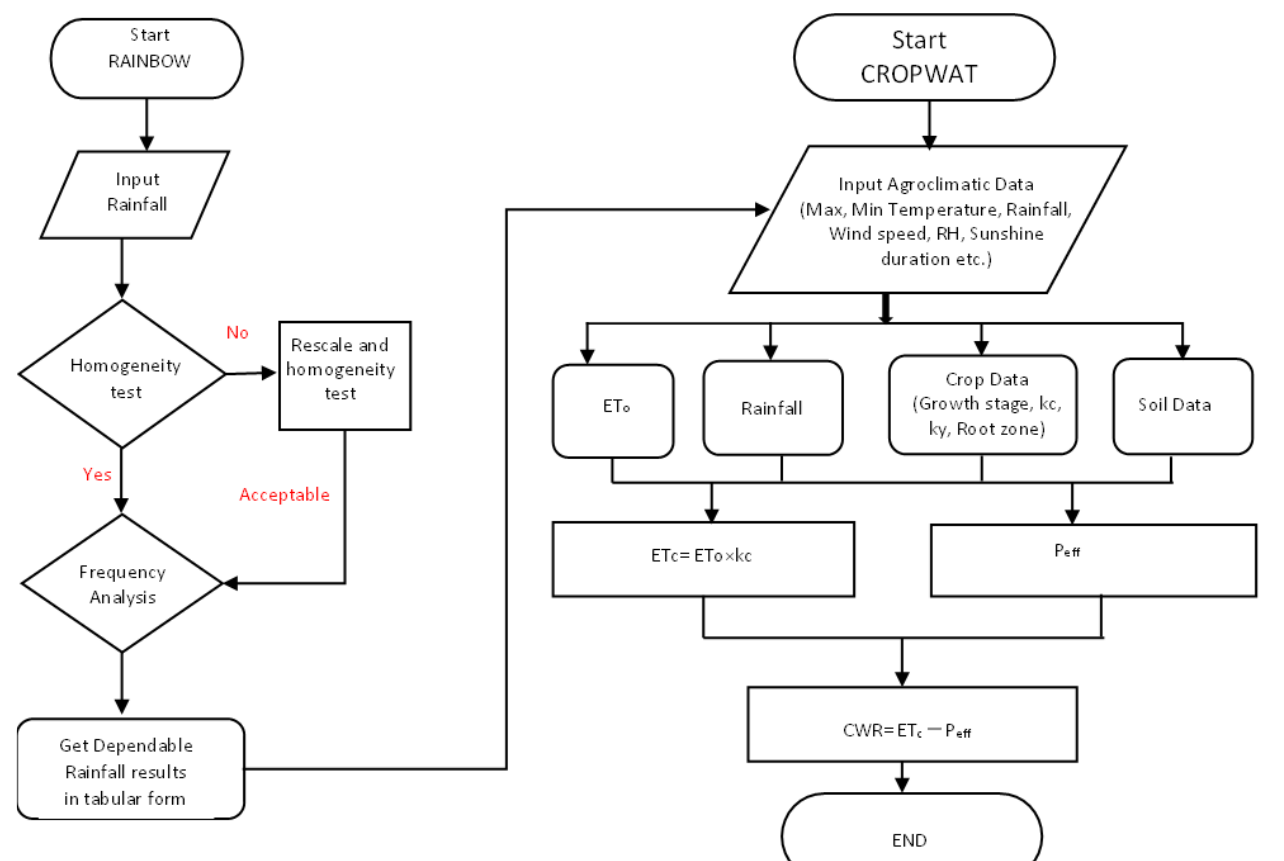
Figure 1. Flowchart of the methodology (Cropwat section of the flowchart was adapted from Kattak et al. [29]). ETo: reference evapotranspiration, ETc: evapotranspiration of the crop, Peff: effective rainfall, RH: relative humidity, kc: crop coefficient, ky: yield response to water, CWR: crop water requirement.